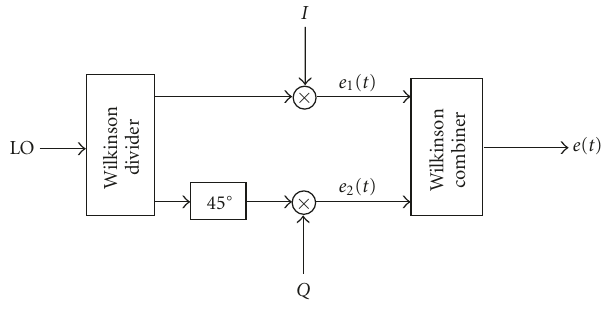
Figure 10: Modulator scheme.